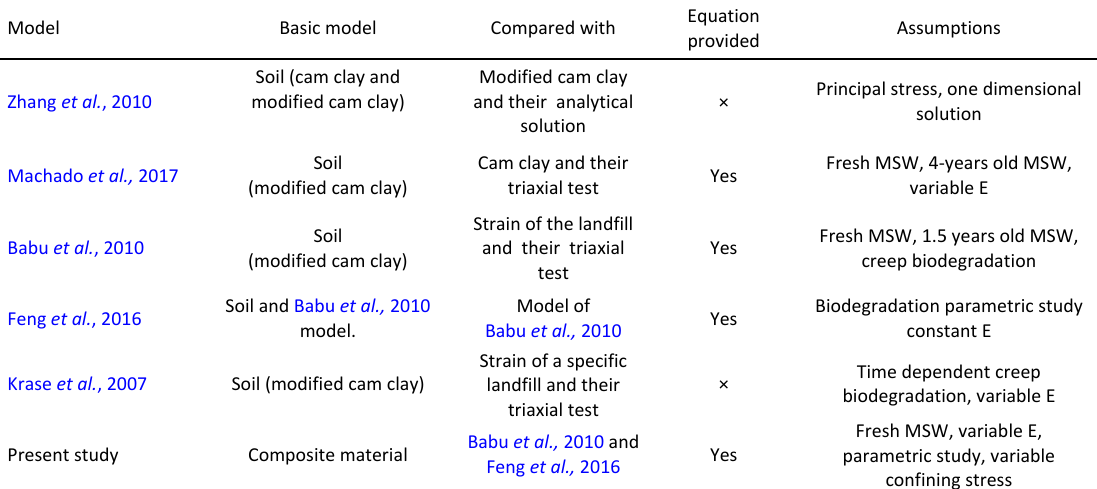
Table 1: Comparision between the developed constitutive models for predicting the MSW behavior